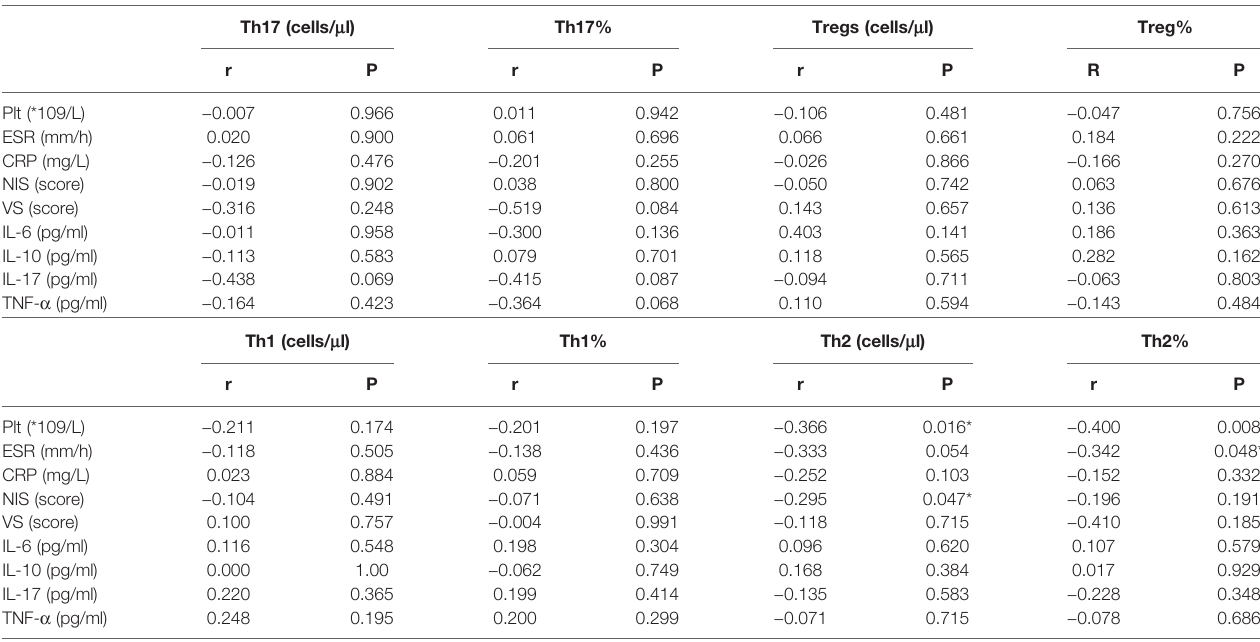
TABLE 1 | Correlation analysis.